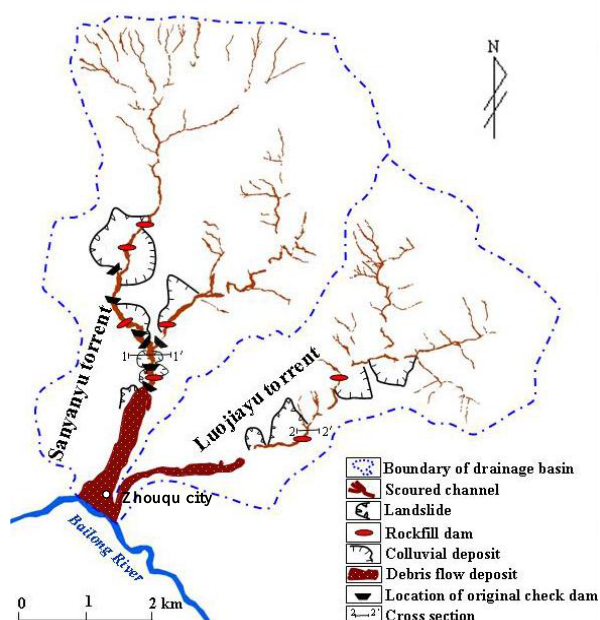
Fig. 3. Geomorphological sketch map of the Sanyangyu and Luojiayu catchments based on field investigations combined with the interpretation of a Quickbird image taken on 15 August 2010 (immediately after the Zhouqu debris flows occurrence).